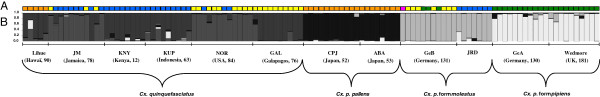
Comparison of wPip groups (A) with Cx. pipiens genetic clusters revealed by Bayesian analysis using microsatellites loci (B). Each of the 113 individuals included in the analysis is represented by a vertical line, partitioned into five squares assigned different colours (blue, wPip-I infection; green, wPip-II; yellow, wPip-III; pink, wPip-IV; orange, wPip-V) (A) and segments of different colours that represent the individual’s probability of belonging to one of the four genetic clusters (black, pallens; medium and dark grey, quinquefasciatus; soft grey, molestus; white, pipiens) (B). Specimens were grouped by location (bracketed), and the indicated population numbers are the same as in Additional file
1: Table S1.